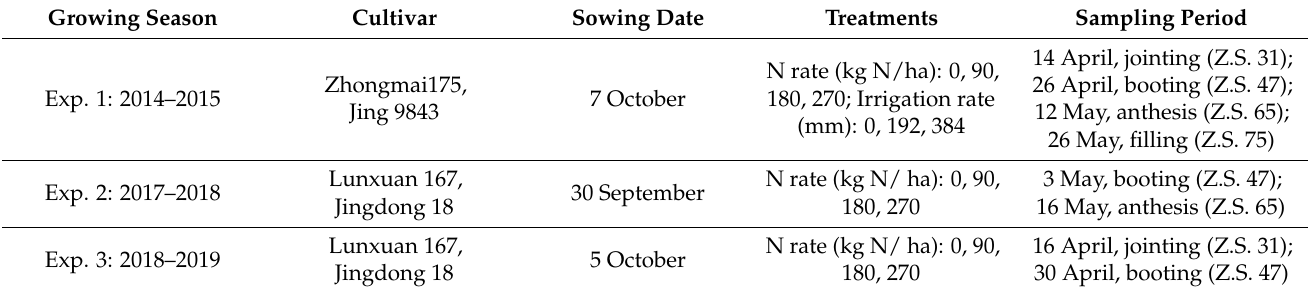
Table 1. Summary of the treatments used in the three winter wheat field